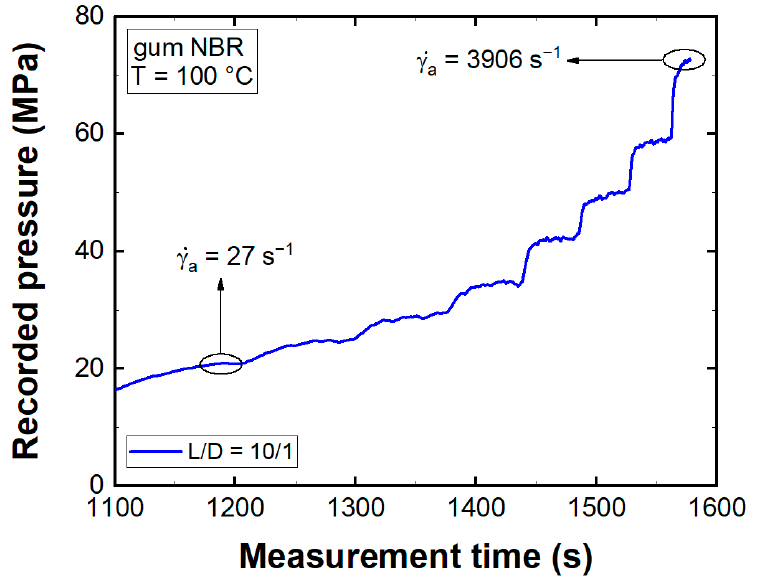
Figure A6. Recorded pressure in the L/D = 10/1 capillary die in dependence of the measurement time with apparent shear rate levels displayed ranging from 27 s − 1 to 3906 s − 1 .